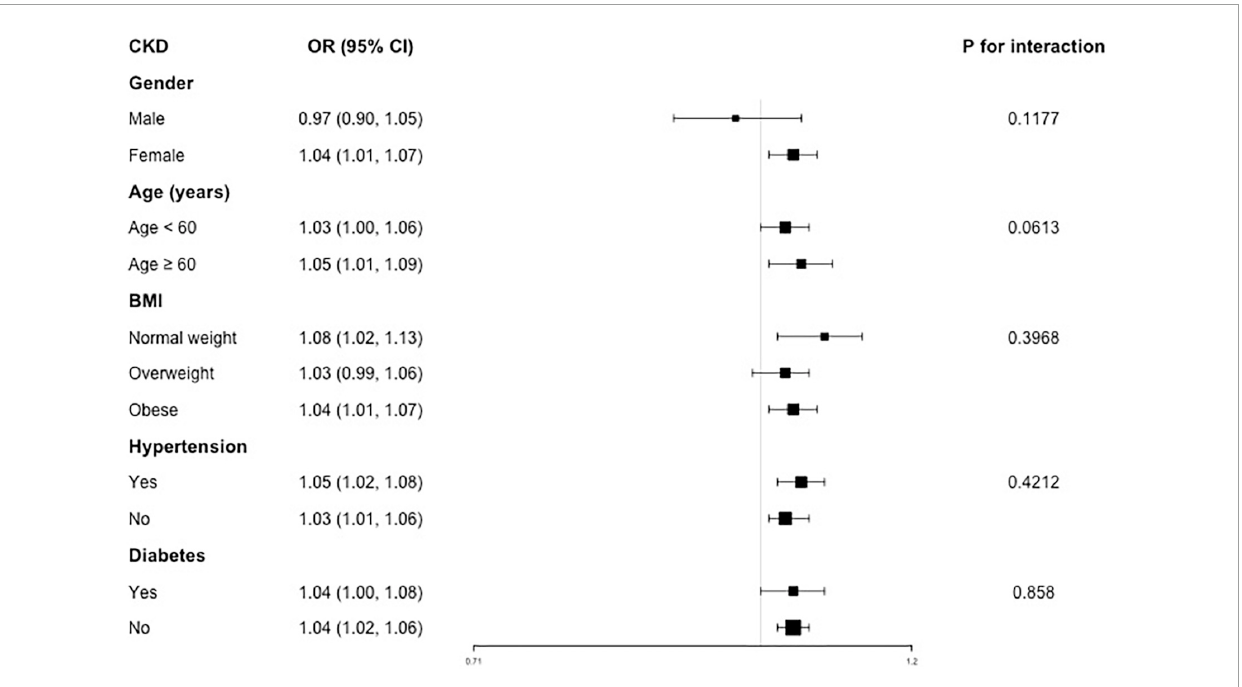
FIGURE4 Subgroup analysis for the association between VAI and